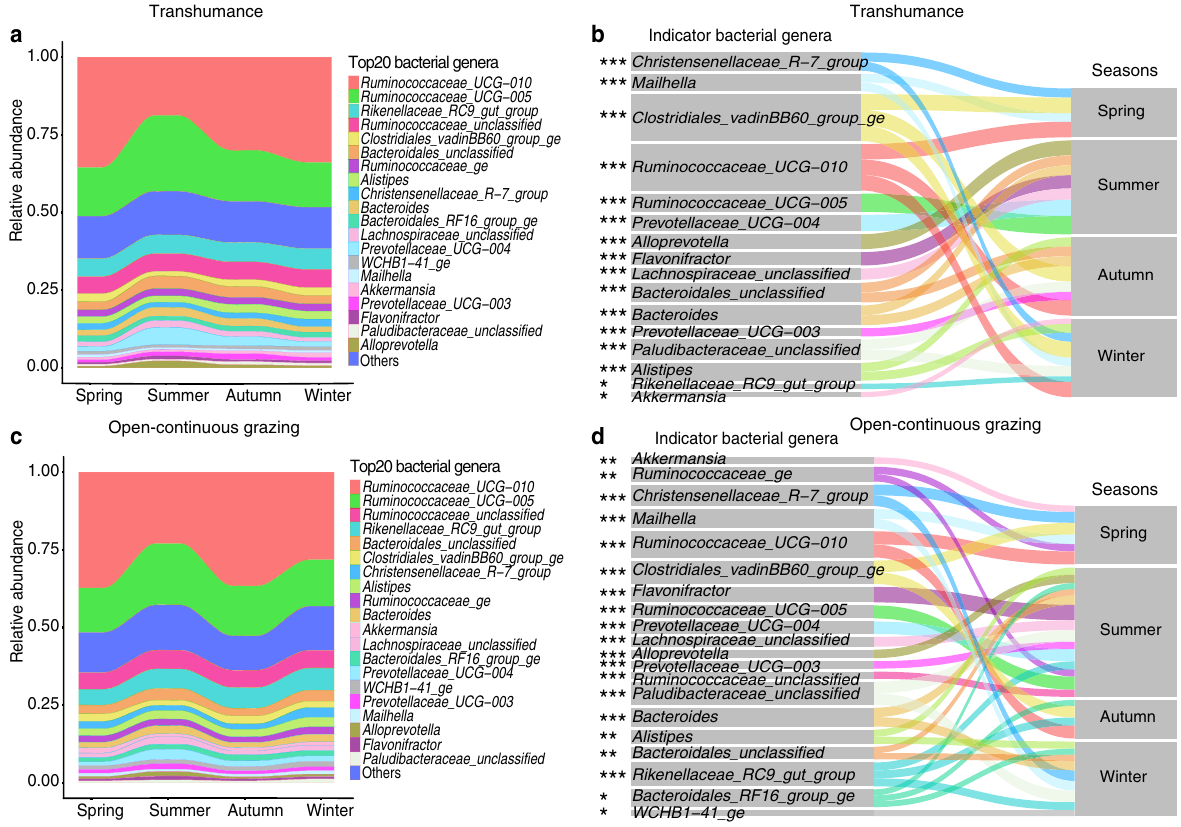
Fig. 4 Seasonal variations of yak gut microbiota at the genus level in transhumance and open-continuous grazing regimes. Relative abundance of the 20 most abundant genera over seasons (spring, summer, autumn, and winter) are aggregated and colored on a stream- graph in ( a ) transhumance and ( c ) open-continuous grazing regimes. Low abundance taxa (except for 20 most abundant genera) are grouped together as “ others ” . Indicator genera that are related to each season are tracked using Sankey plots in transhumance ( b ) and open-continuous grazing ( d ) regimes. Lines represent associations between indicator genera and seasons, which are colored by genus level. Line width is scaled to re fl ect indicator value (higher indicator value of genus is more strongly associated with the season). Indicator value are shown in Supplementary Fig. 7. The statistical p values mean the genus associated with seasons. * p < 0.05, ** p < 0.01, *** p <